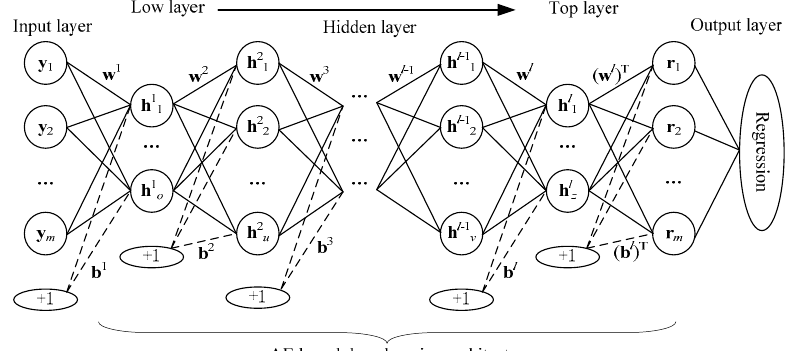
Figure 1. Structures of the autoencoder (AE)-based deep regression network (DRN) model. w l and b l represent the connection weight matrix and bias values between neighboring layers (( l -1)-th and l -th layers), respectively.